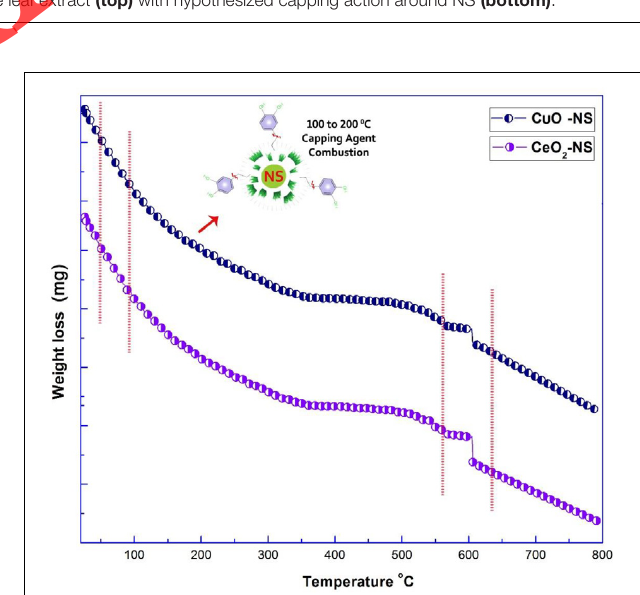
FIGURE 2 | HPLC chromatogram showing major compounds present in the olive leaf extract (top) with hypothesized capping action around NS (bottom) .